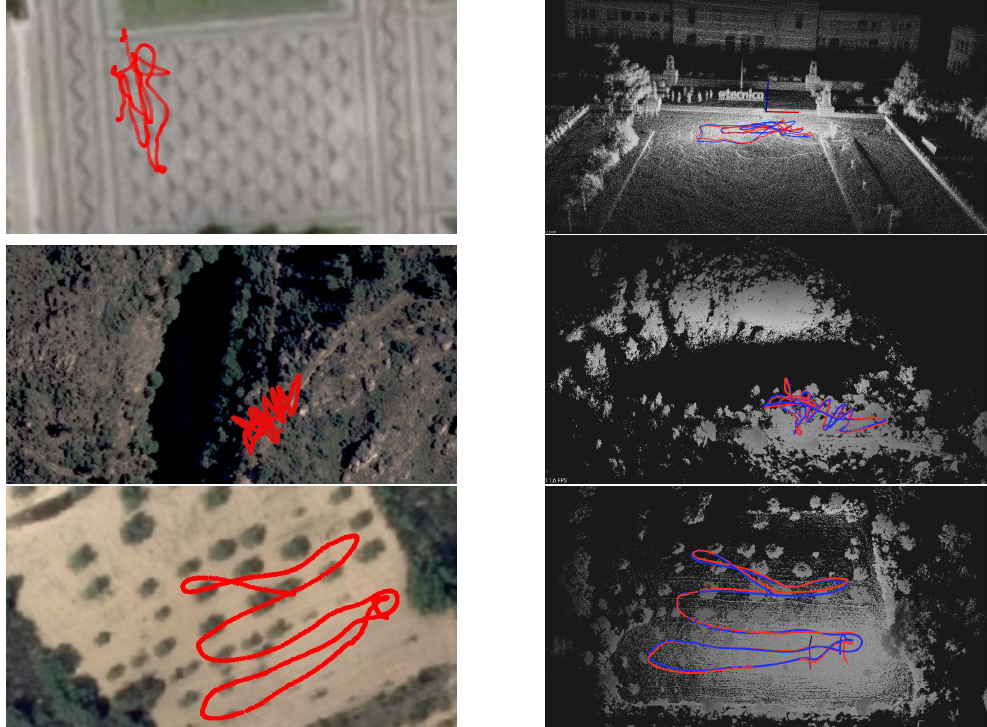
Figure 19. Left : GNSS path overlaid on satellite view. Right : 3D maps generated from LIDAR data running ALOAM algorithm, with lines representing estimated flight paths from LIDAR and GNSS data (blue and red, respectively). Scenarios A, B and C from top to